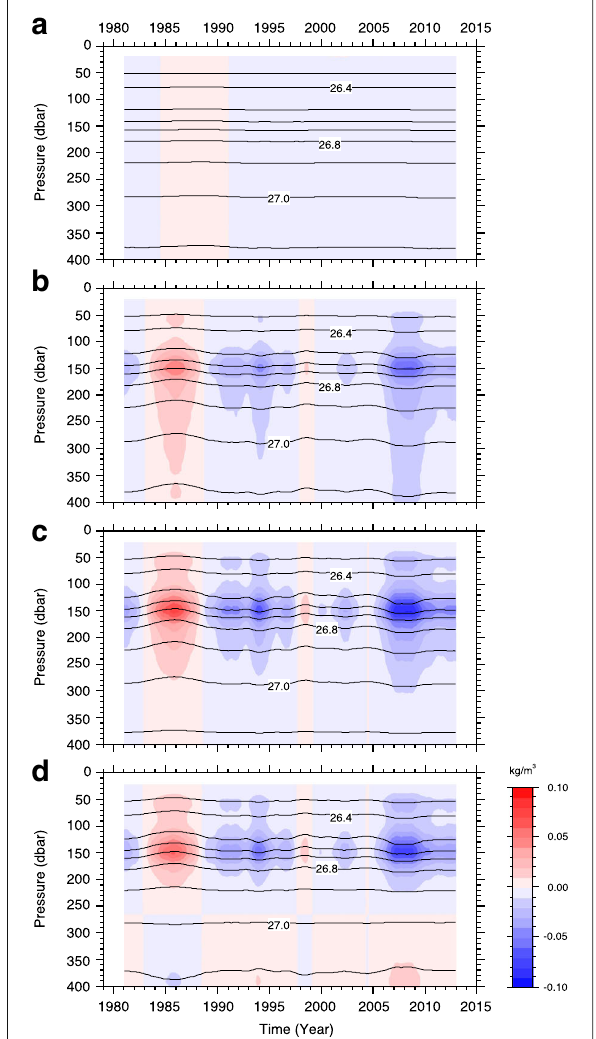
Fig. 18 Potential density ( σ θ , contours) and variations (kgm − 3 , color shades) in the top 400dbar layer due to the a first ( n = 1), b second ( n = 2), c third ( n = 3), and d fourth ( n = 4) baroclinic modes of the Rossby waves forced by the wind stress. The contour interval is 0.1kgm − 3 . Smoothing was performed using a 49-month running mean